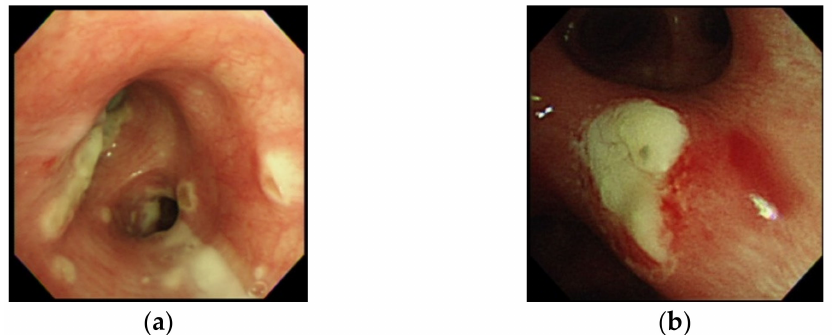
Figure 1. Bronchoscopic examination in case 17 with influenza-associated pulmonary aspergillosis (IAPA) due to A. fumigatus , which demonstrated vesicles and whitish patches over bilateral bronchial tress ( a ), and in case 23 with IAPA due to A. flavus , which demonstrated an area of whitish plague over left secondary carina that was difficult to remove ( b ), but resolved under voriconazole in a follow-up bronchoscopic examination eight days later. Table 4. Aspergillus isolates recovered from 24 patients with influenza-associated pulmonary